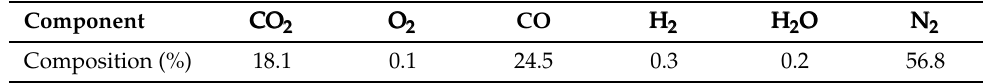
Table 1. Mass fraction of the fuel